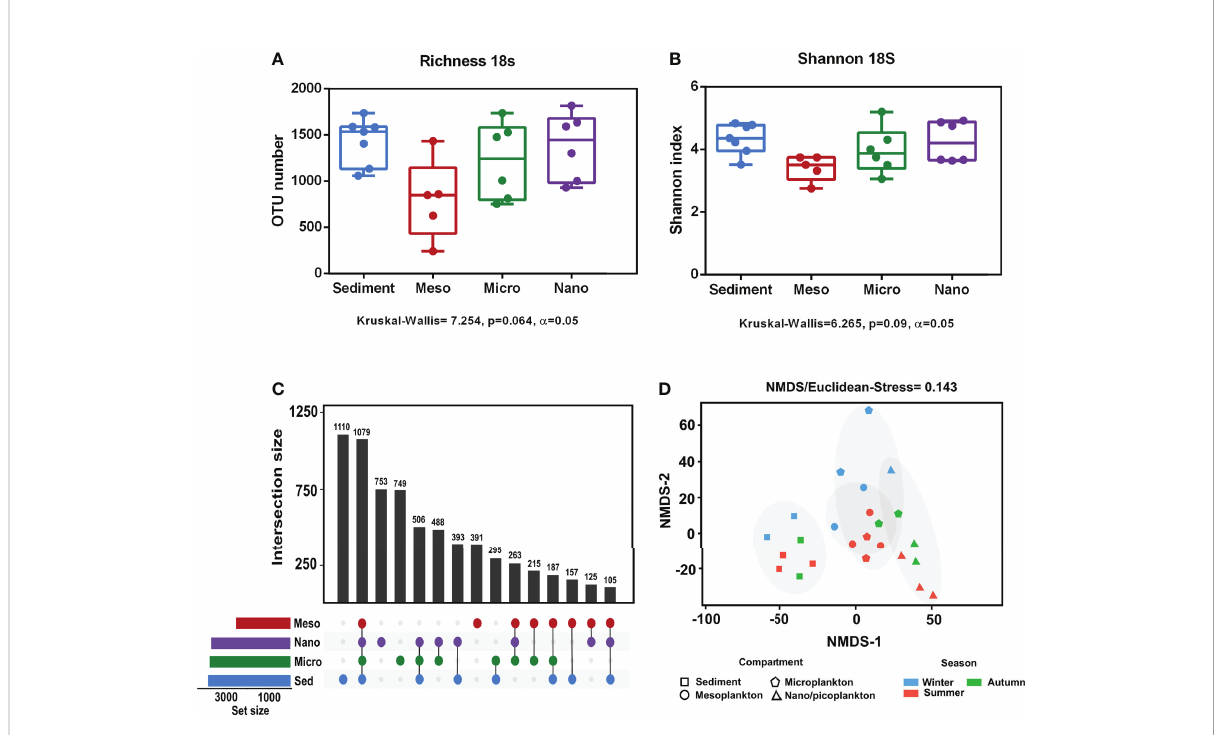
FIGURE 3 Alpha and beta diversity obtained from eukaryote sequencing. (A) Richness and (B) Shannon index obtained from each environmental compartment. (C) Exclusive and common OTUs of eukaryotes obtained from each environment. (D) NMDS based on Euclidean distances. The stress value indicated a reliable level of